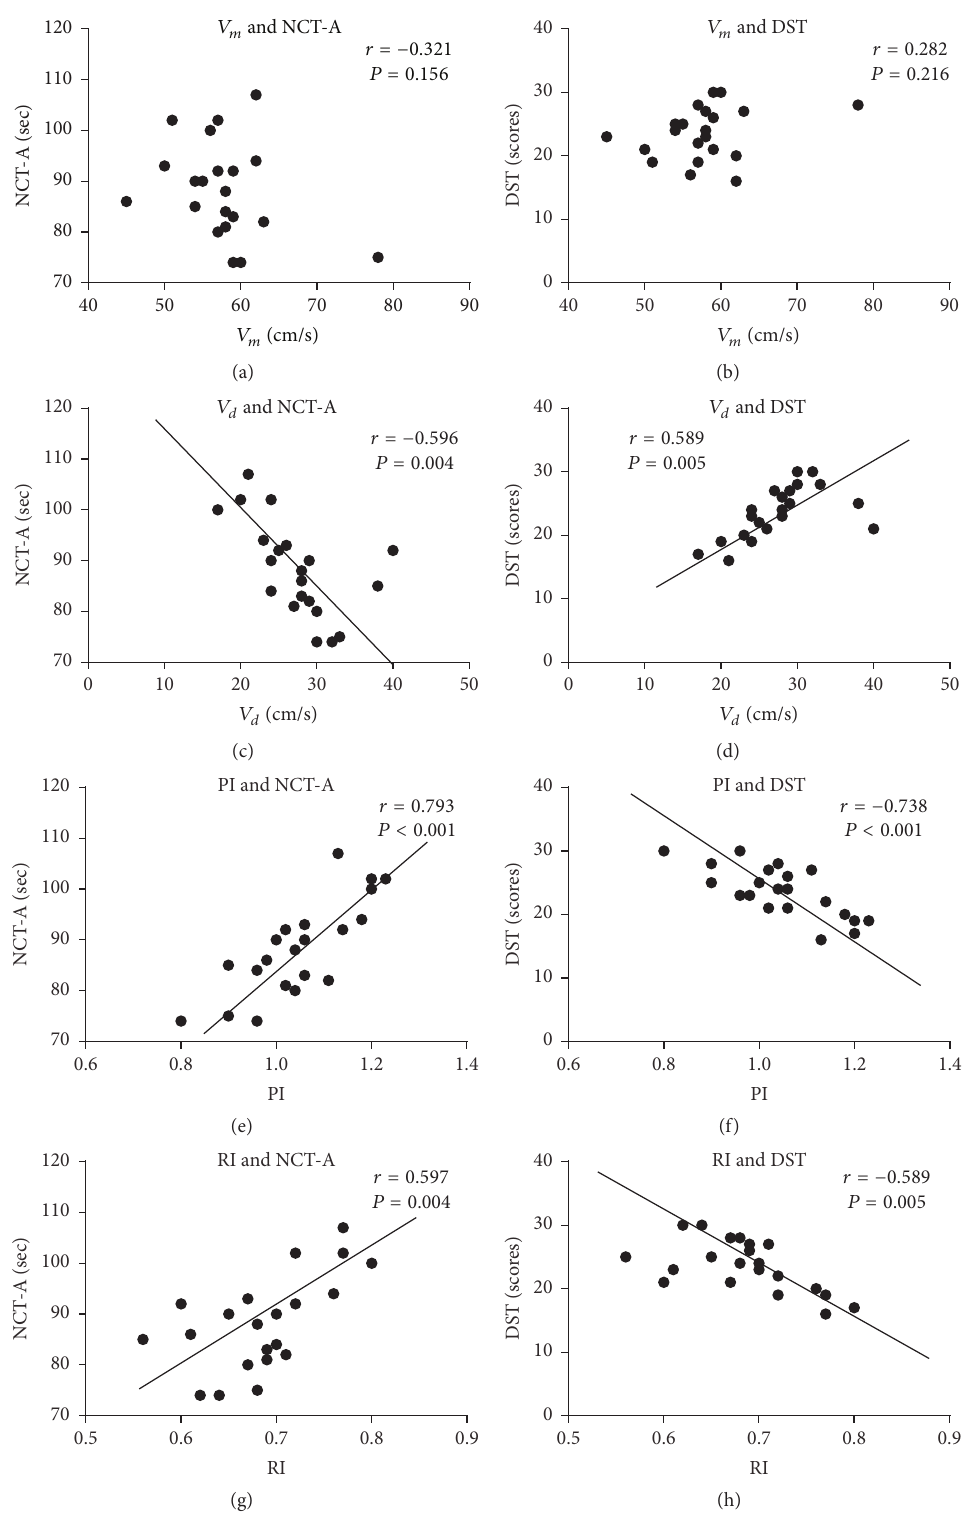
Figure 4: Correlation between cerebral hemodynamics ( 𝑉 𝑚 , 𝑉 𝑑 , PI, and RI) and declining cognitive function (NCT-A and DST) in patients with MHE . It includes the subfigures (a, b, c, d, e, f, g, and h). Subfigure (a) is correlation between 𝑉 𝑚 and NCT-A. Subfigure (b) is correlation between 𝑉 𝑚 and DST. Subfigure (c) is correlation between 𝑉 𝑑 and NCT-A. Subfigure (d) is correlation between 𝑉 𝑑 and DST. Subfigure (e) is correlation between PI and NCT-A. Subfigure (f) is correlation between PI and DST. Subfigure (g) is correlation between RI and NCT-A. Subfigure (h) is correlation between RI and DST. Correlation was analyzed by Pearson’s correlation coefficient. 𝑃 < 0.05 means significant differences in correlation between two